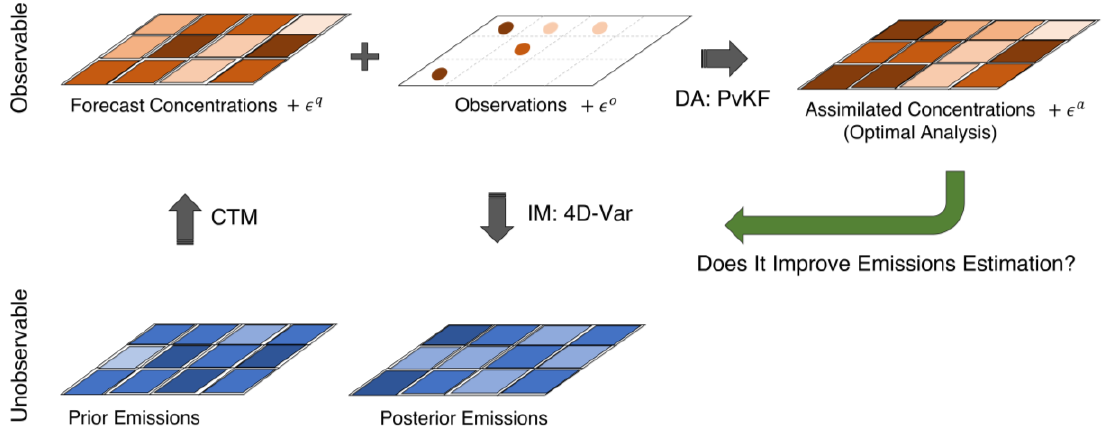
Figure 1. Schematic view of using the cost-efficient PvKF assimilation system for estimating methane emissions through 4D-Var inversion. Chemical Transport Model (CTM), PvKF Data Assimilation (DA), and 4D-Var Inverse Modelling (IM) systems are shown by grey arrows. ϵ 𝑞 , ϵ 𝑜 , and ϵ 𝑎 represents model, observation, and analysis error, respectively.